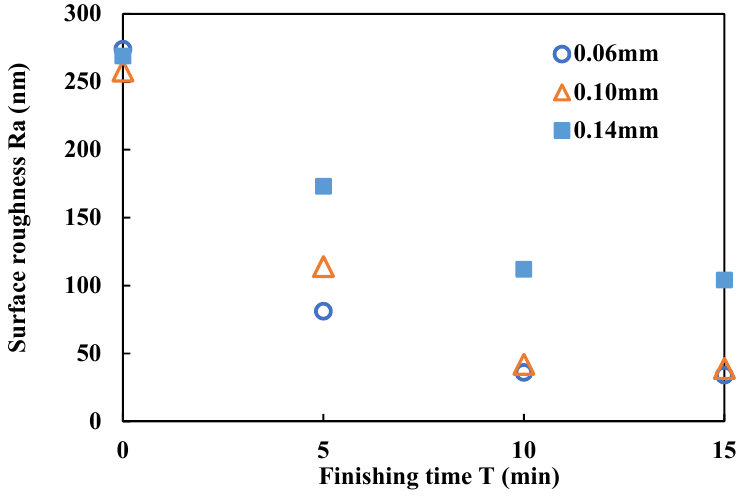
Figure 16. States of compound magnetic finishing fluid leaving the finishing area with different working gaps.